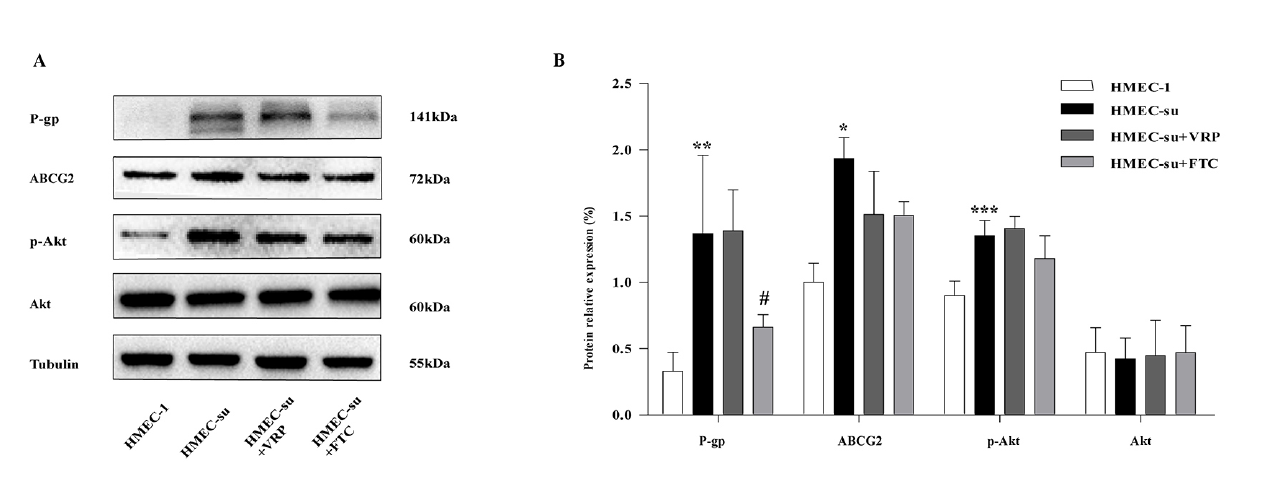
FIGURE S2 - Effect of P-gp and ABCG2 inhibitors on P-gp and ABCG2 proteins expression. Expression of P-gp, ABCG2 and p-Akt, Akt protein in HMEC-1 and HMEC-su cells was determined by Western blotting. Cells were treated with verapamil (VRP) at 100 µM and ABCG2 inhibitors fumitremorgin C (FTC) at 5 µM for 48h. All data were collected from three independent experiments, **P < 0.01 and *P < 0.05 vs. HMEC-1 cells, # P < 0.05 vs. HMEC-su